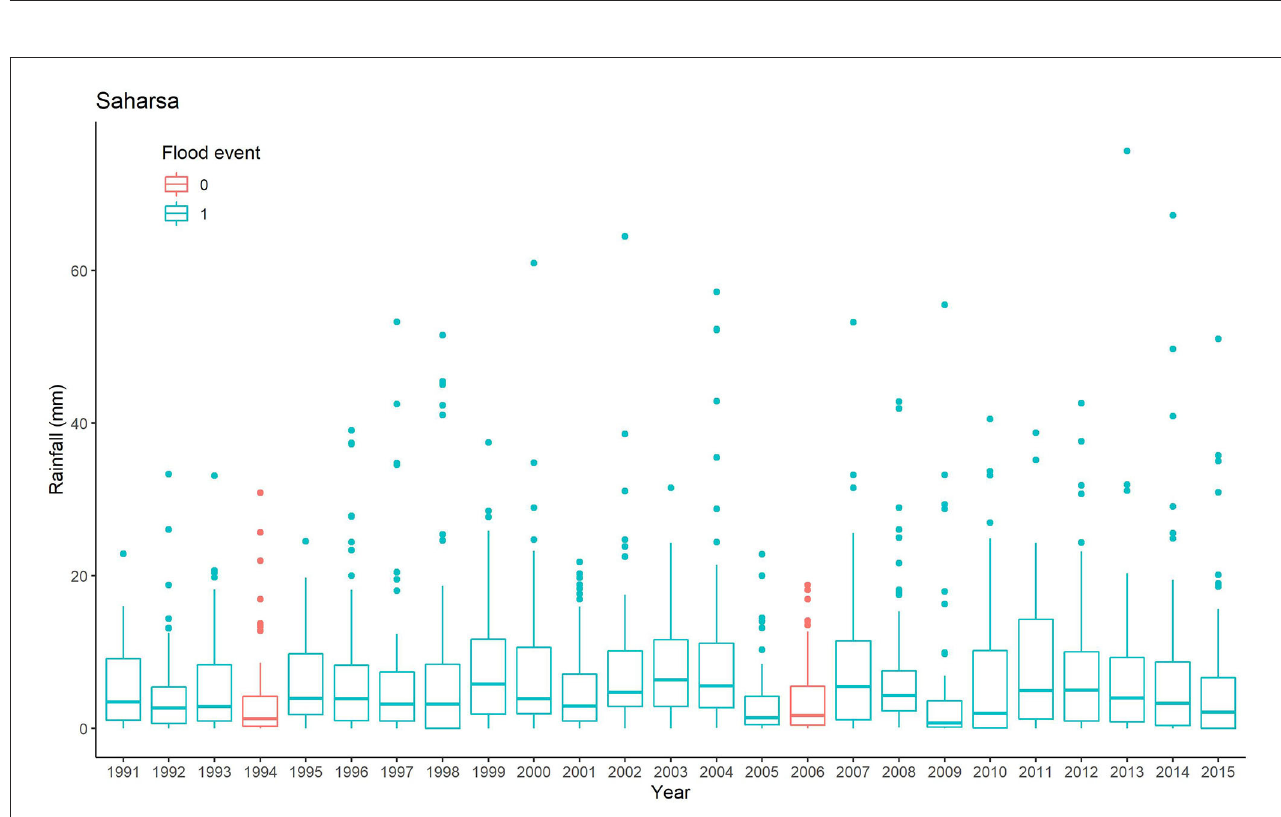
FIGURE5 Saharsa_monthly rainfall_flood